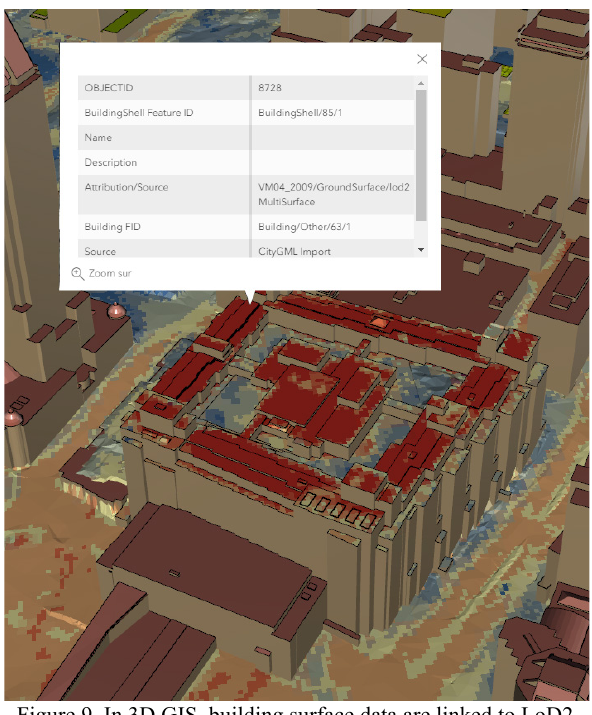
Figure 9. In 3D GIS, building surface data are linked to LoD2- roof and land surface are linked to the cadastre (properties limits) in